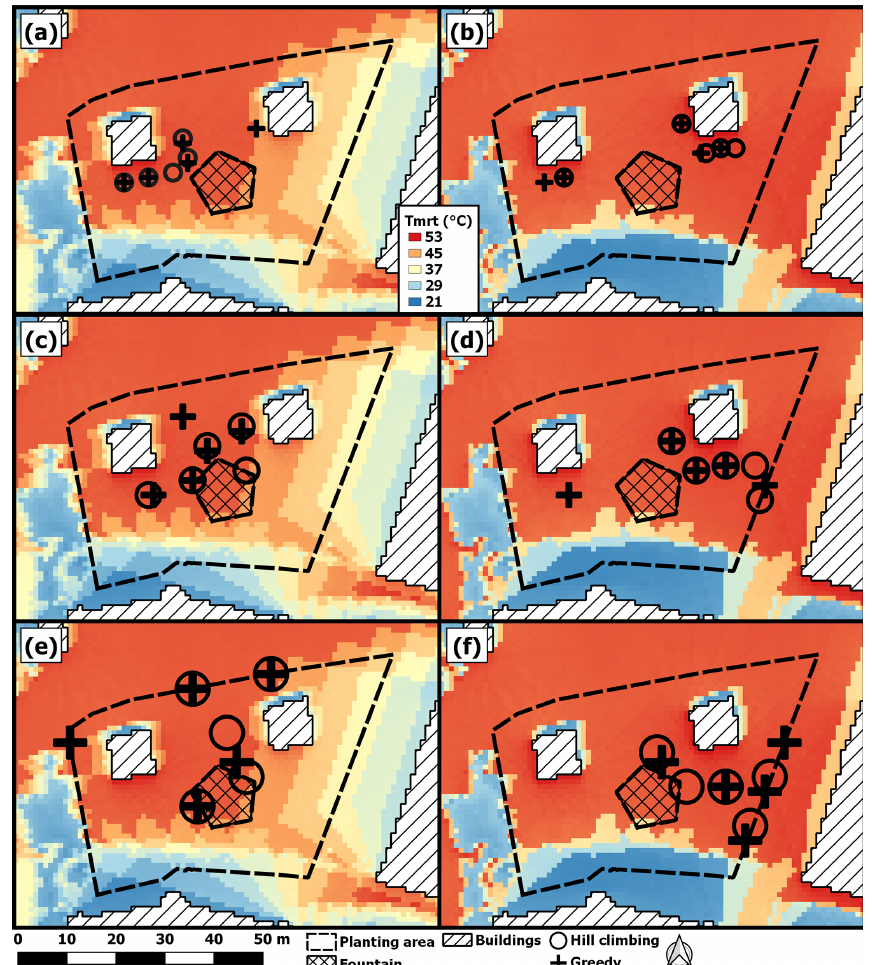
Figure 10. Locations for trees from the hill-climbing algorithm with the genetic starting algorithm and 20000 iterations, and the greedy algorithm. The left column (a, c, e) and the right column (b, d, f) are for 09:00–16:00 and 13:00–16:00LST, respectively, on 22 June 1983. Panels (a) and (b) are with small trees, (c) and (d) with medium trees and (e) and (f) with large trees. The underlying map shows mean T mrt for the respective time periods from which the locations were